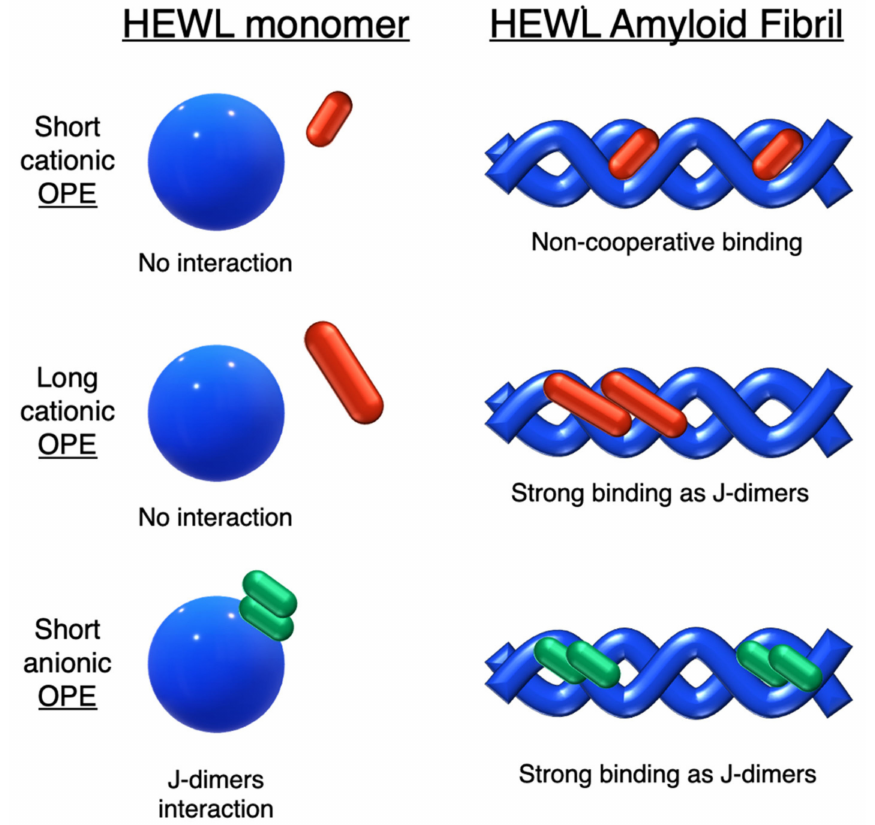
Figure 4. Schematic illustration of binding modes of OPEs 18d - f (in red) and 19c (in green) with HEWL and HEWL